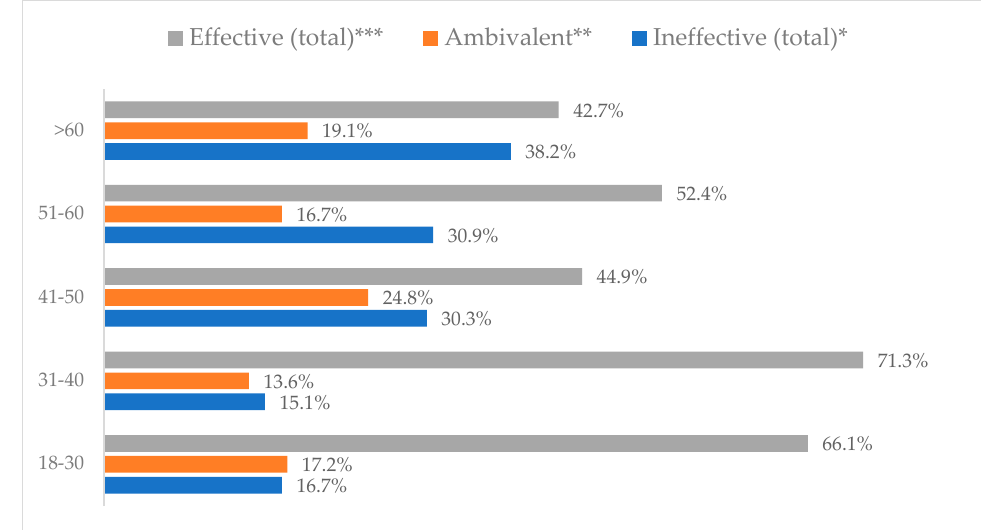
Figure 11. Influenza vaccination to prevent influenza virus infection by gender ( N = 905). *Sum of responses: completely ineffective, ineffective, rather ineffective; **Response: neither ineffective nor effective; ***Sum of responses: rather effective, effective, completely effective.